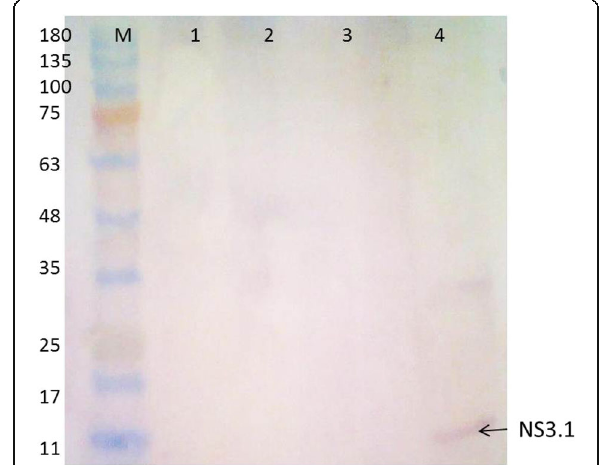
Fig. 7 NS3.1 antigenic recombinant protein expressed in bacterial cells (gene-specific antibodies). Lanes 1 – 4: NS3.1 protein; lane 4: positive NS3.1; M: prestained protein marker.